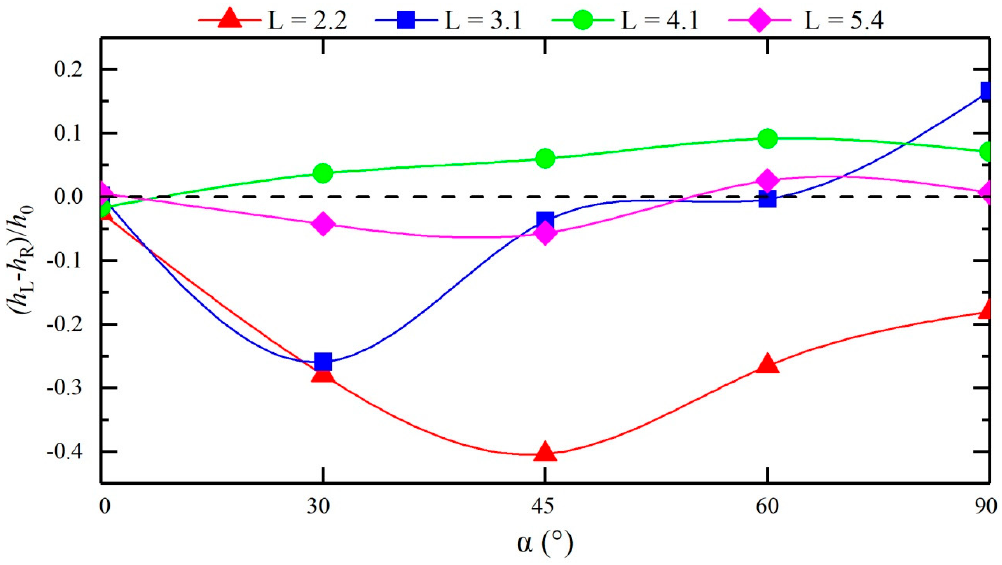
Figure 9. Comparison of the difference between the wave peaks at the left and right banks at each cross-section of the downstream straight section of each configuration.